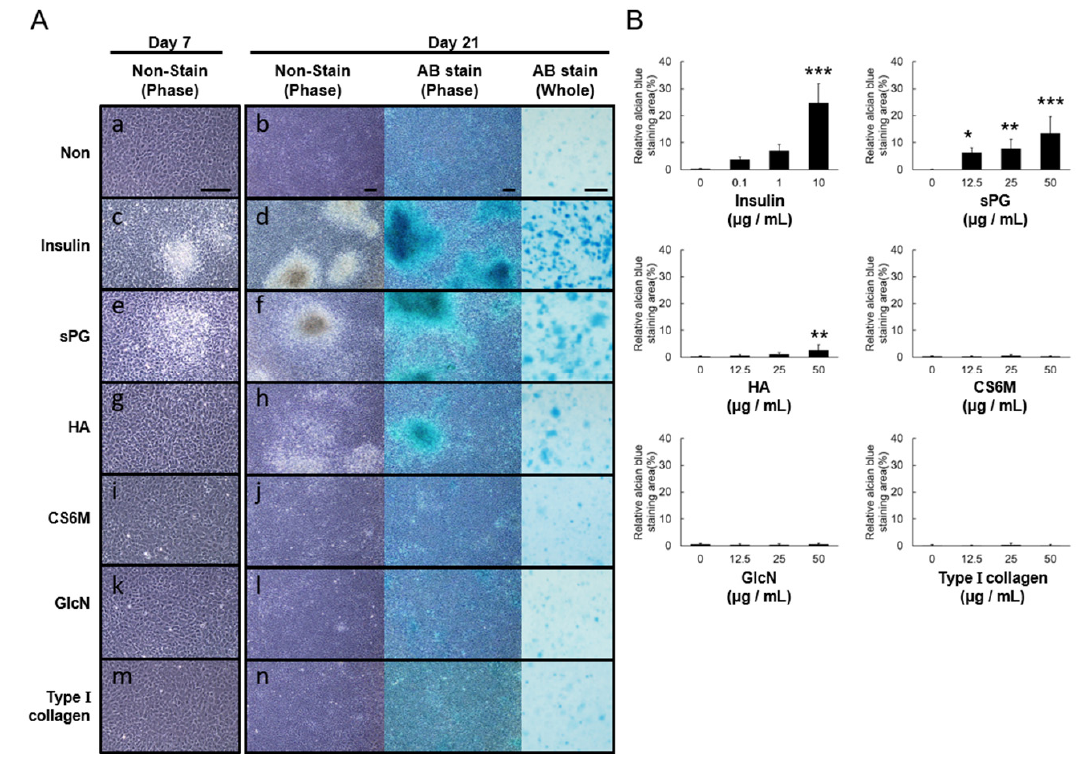
Figure 3. Comparison of chondrogenic di ff erentiation e ff ect in ECM components on ATDC5 cells. ( A ) Cell morphology of ATDC5 cells by phase-contrast micrographs. ATDC5 cells were then incubated in the absence ( a ) or the presence (50 µ g / mL) of the matrix components sPG ( e ), HA ( g ), CS6M ( i ), GlcN ( k ) and type I collagen (m) under DME / F12 medium containing 5% FBS at 37 ◦ C in a humidified atmosphere of 5% CO 2 in air for another 7 days. Insulin ( c ) (10 µ g / mL) was used as a positive control of chondrogenic di ff erentiation induction. The cell morphology was observed with phase-contrast microscopy by non-stain Alcian blue (AB) staining of ATDC5 cells. ATDC5 cells were then incubated in the absence ( b ) or the presence (50 µ g / mL) of the ECM components sPG ( f ), HA ( h ), CS6M ( j ), GlcN ( l ) and type I collagen ( n ) for 21 days from post-confluence. Cells were stained with 0.1% Alcian blue in 0.1 M HCl overnight. Cell morphology images before staining and Alcian blue-stained images on day 21 were observed with phase-contrast microscopy. The whole images were acquired with a digital camera. Insulin ( d ) (10 µ g / mL) was used as a positive control. ( B ) Image quantitative evaluation of chondrogenic di ff erentiation. The obtained whole images were quantified by WinROOF software. These data are presented as the mean ± S.D. of three independent experiments. Significant di ff erences show * p < 0.05; ** p < 0.01; *** p < 0.001 vs. 0 µ g / mL as control, Dunnett‘s test. Scale Bar = 200 µ m (phase images), 3 mm (whole image).